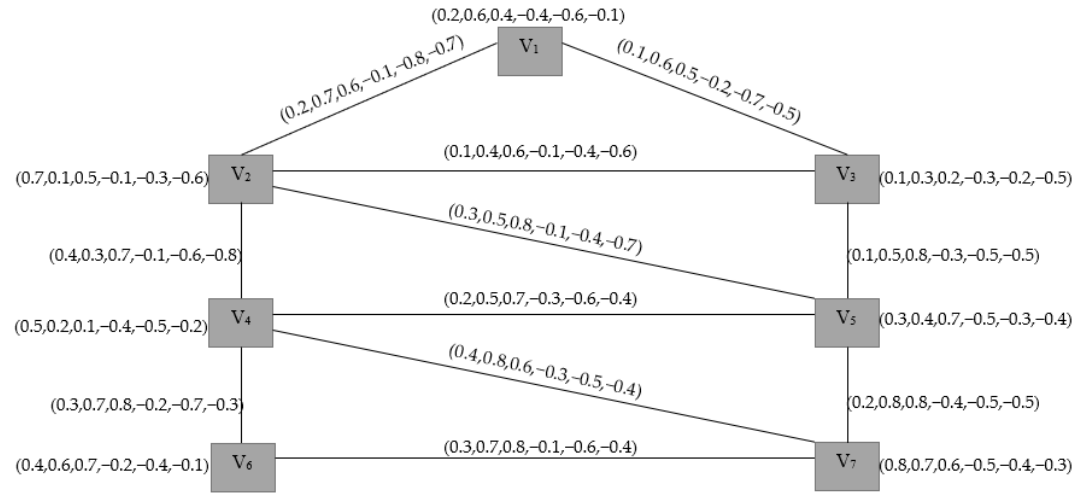
Figure 3. Signless Laplacian energy of a bipolar single-valued neutrosophic graph. The adjacency, degree, and the signless Laplacian matrices of the BSVNG shown in Figure 3 are expressed as follows: